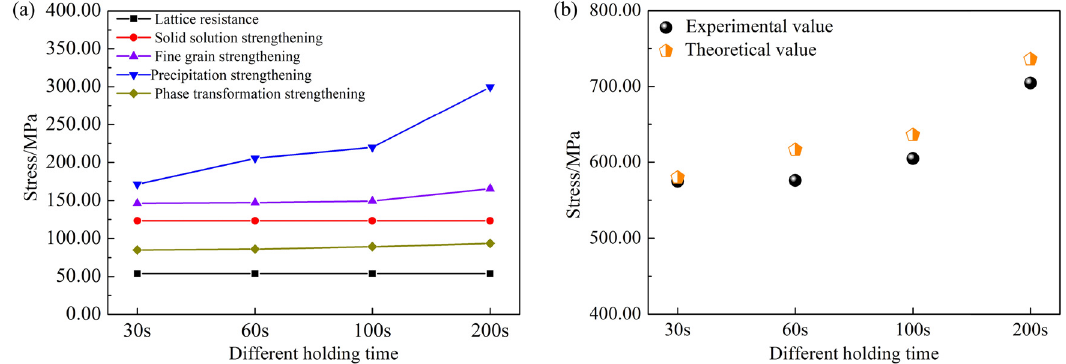
Figure 10: Comparison of strengthening mechanism: ( a ) contribution of strengthening mechanism and ( b ) comparison of theoretical strength and actual